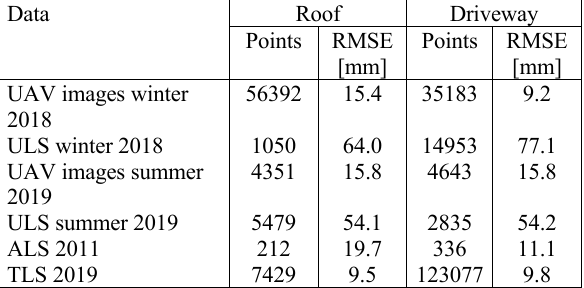
Table 3 . Roughness of point cloud measured as the RMSE of fitting plane to point cloud for part of the roof (13 m 2 ), and driveway (22 m 2